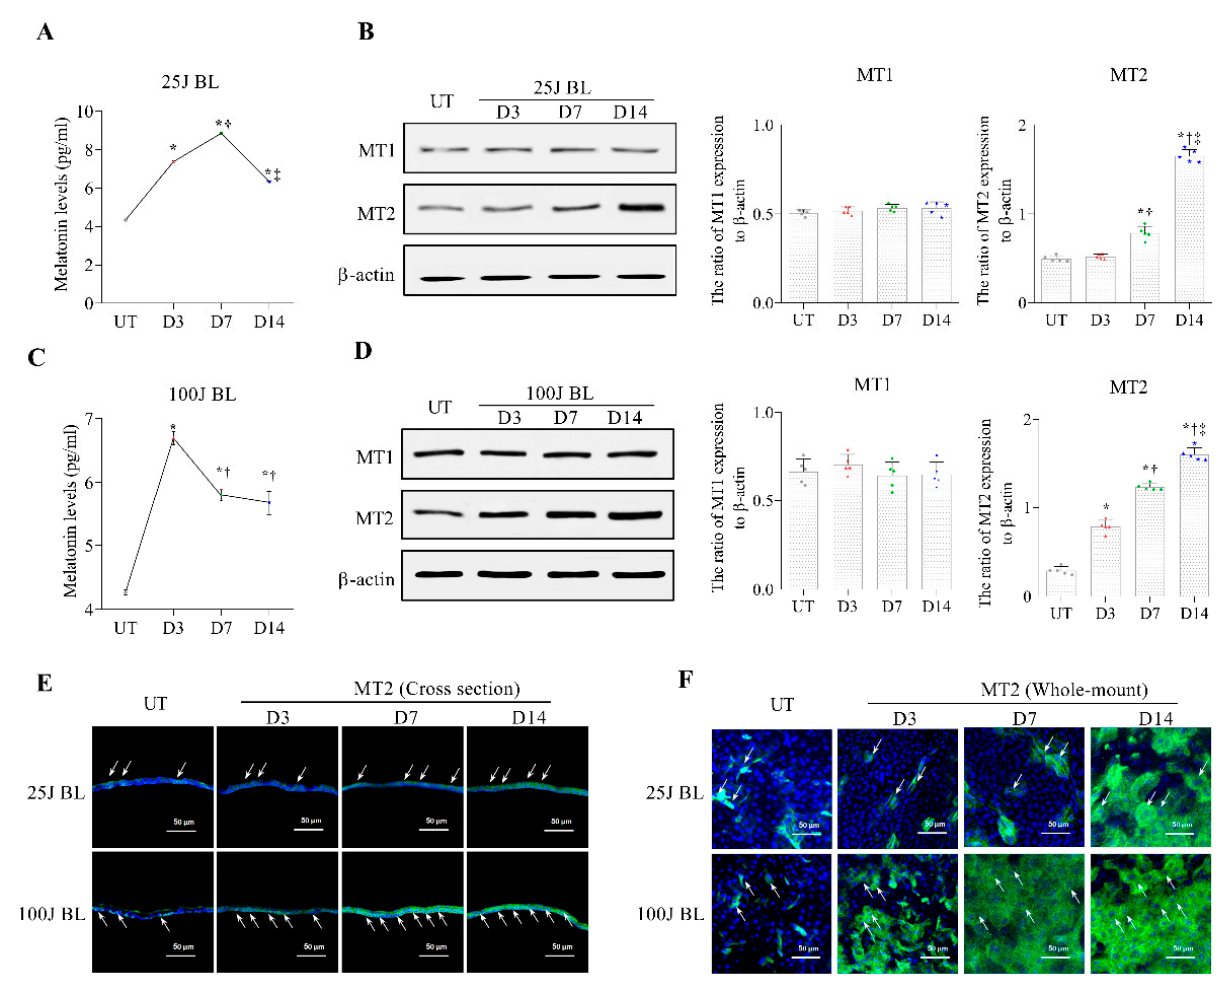
Figure 3. ELISA for melatonin levels ( A , C ) in the cornea of the UT, 25J BL, and 100J BL groups, after 14 days of BL exposure. Western blotting ( B , D ) for the expression of MT1 and MT2 in the cornea and IHC ( E , F ) for MT2 expression at days 3, 7, and 14. * p < 0.05 vs. UT, † p < 0.05 vs. D3, ‡ p < 0.05 vs. D7; UT, untreated; BL, blue light.